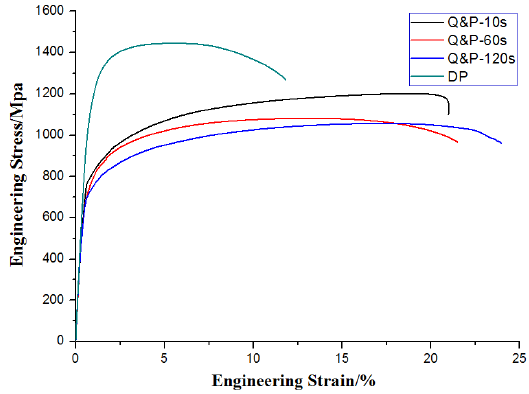
Figure 6. The room temperature tensile engineering.